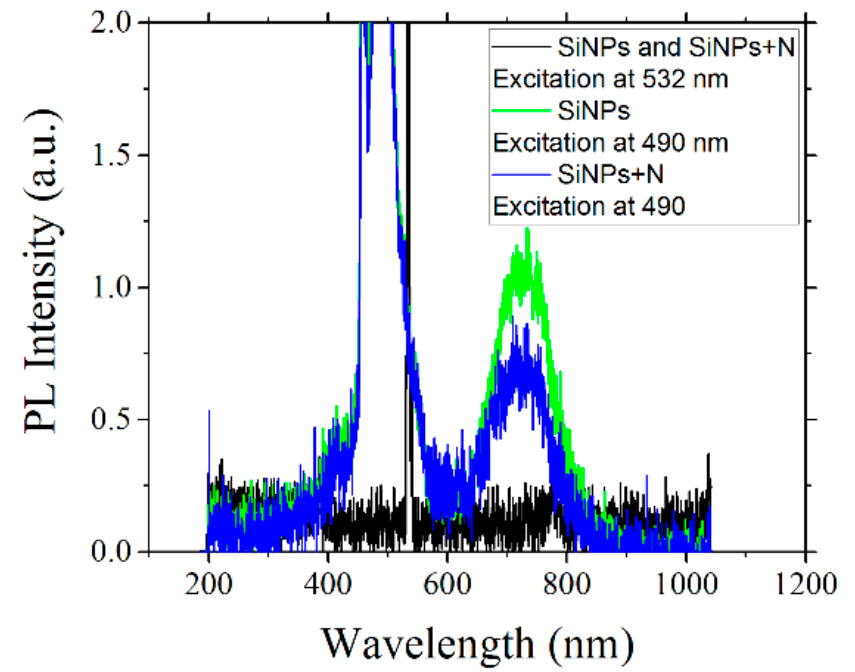
Figure 3. Photoluminescence spectra for the SiNPs and SiNPs+N sample by using two different excitation wavelengths: 490 nm (blue and green plots) and 532 nm (black plot).